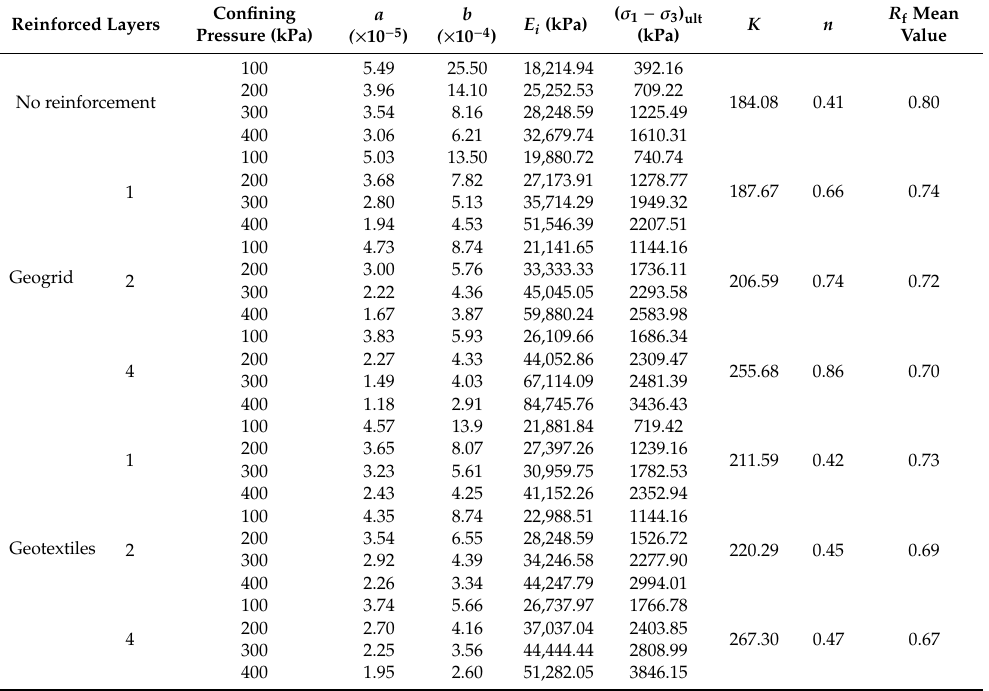
Table 3. Parameters of the Duncan-Chang model with di ff erent reinforced layers of tailings. Reinforced